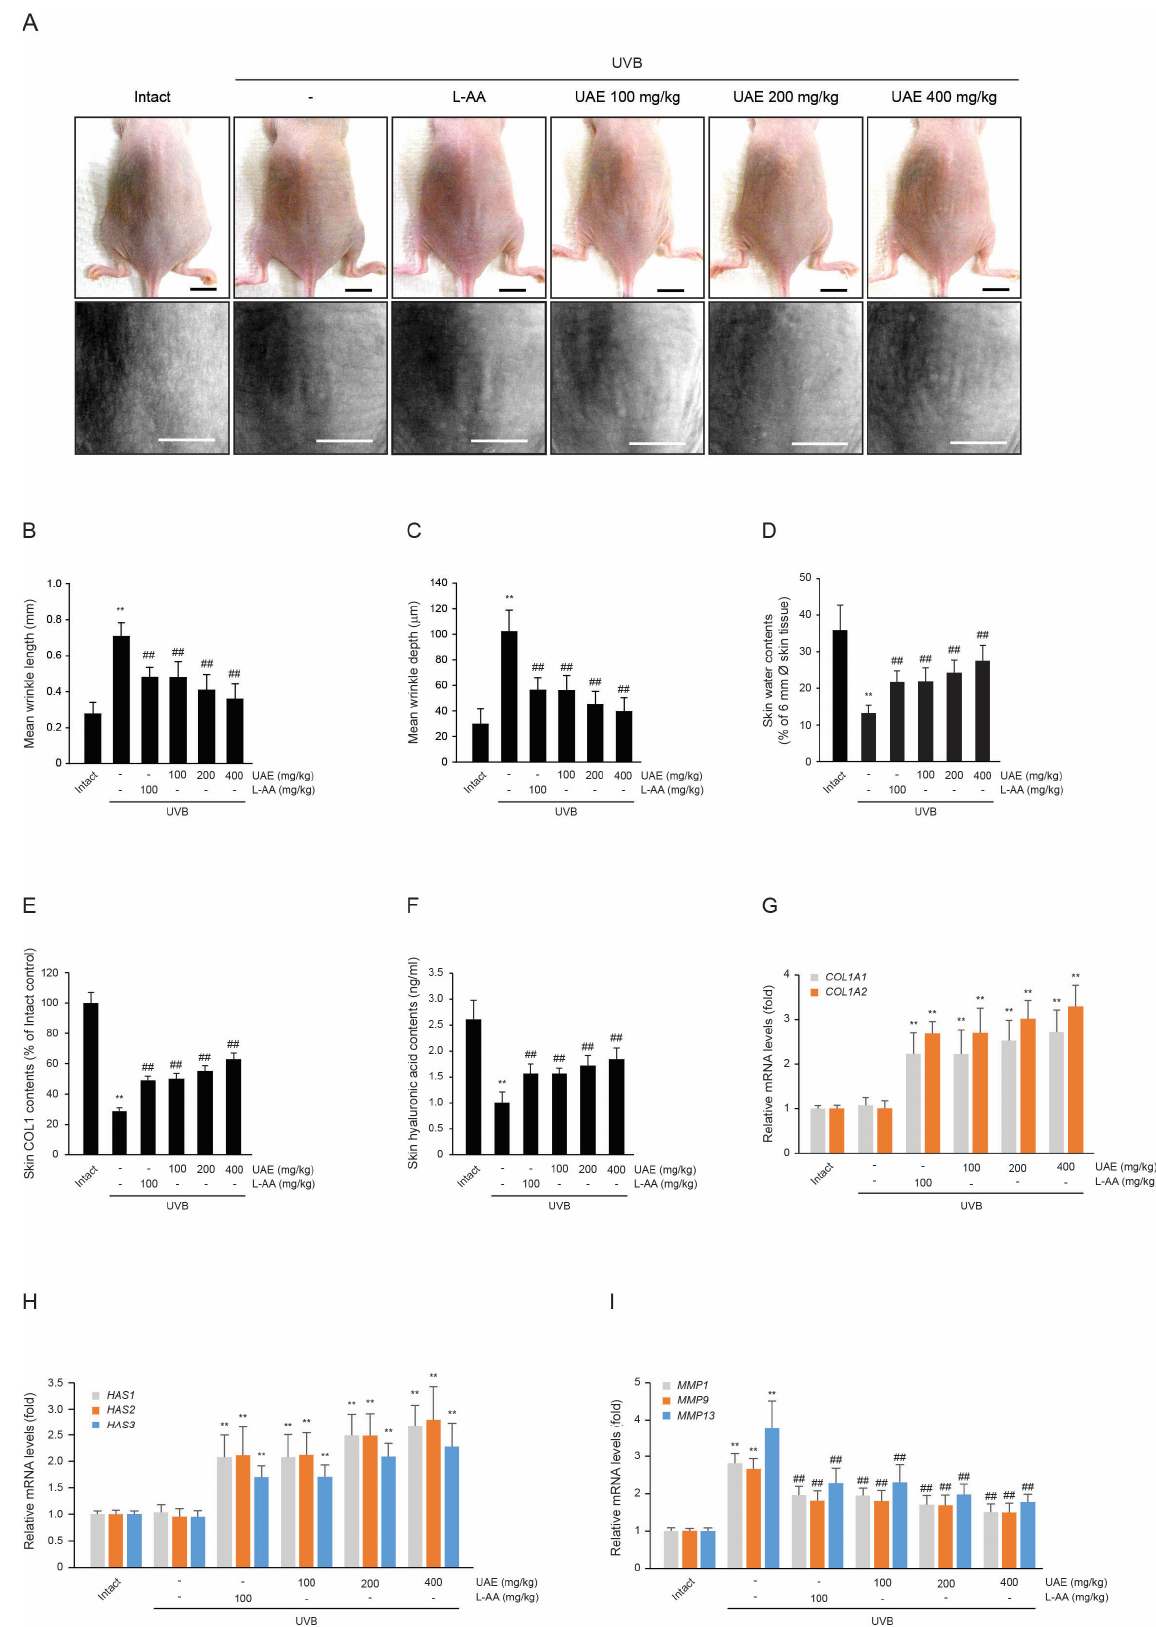
Figure 2. Effects of UAE on UVB-induced wrinkle formation in dorsal back skin. ( A ) Photograph of dorsal back skin (upper), Monochrome image of skin replicas (lower). Scale bars indicate10 mm.